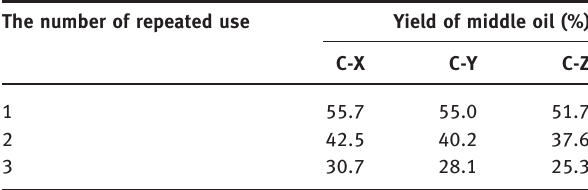
Table 5: The repeated use of the properties of the three kinds of molecular sieve catalyst (conditions: yield of middle oil of C-X, C-Y, and C-Z for three times of repeated